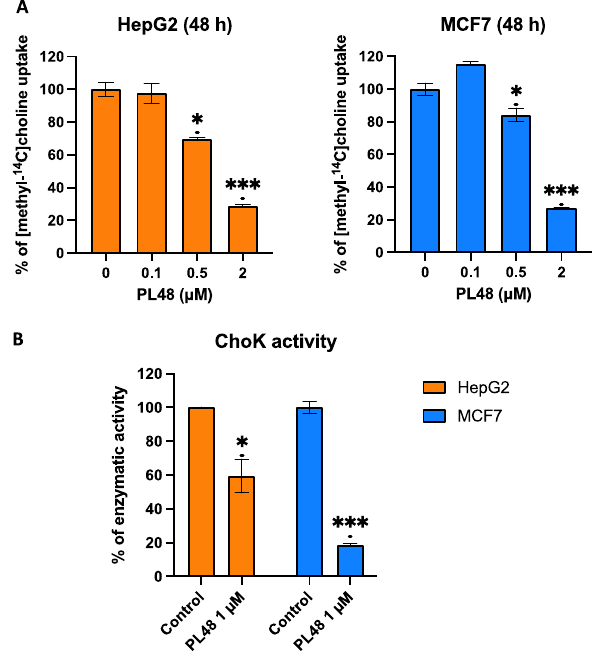
Figure 9. Effects of PL48 treatment on choline uptake ( A ) and on total cellular activity of ChoK ( B ) in HepG2 and MCF7 cancer cell lines. Cells were incubated with the inhibitor for 48 h, and after its withdrawal, choline uptake and ChoK α activity were determined. Data represent the mean ± SEM of two independent experiments conducted in triplicate. Results are normalised to their respective controls. * p < 0.05, *** p < 0.0001.